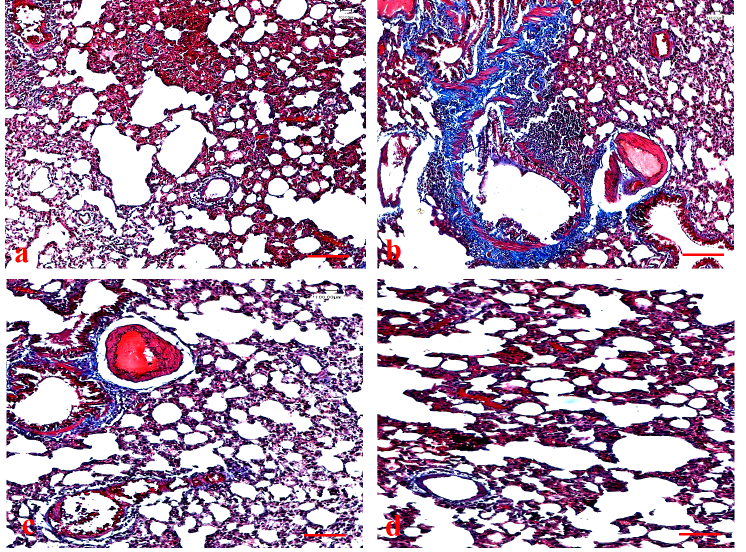
Figure 8. Effect of ADE on lung fibrosis. ( a ) Normal fiber was seen in control group; ( b ) severe collagen deposition in disease control group ( c ) ADE + B(a)P treatment group shows low collagen fibers ( d ) normal collagen in ADE-only-treated group (Scale bar = 100 µ